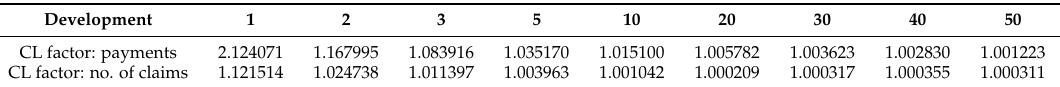
Table 6. Chain-Ladder (CL) estimates of development factors for aggregate payments and the number of reported